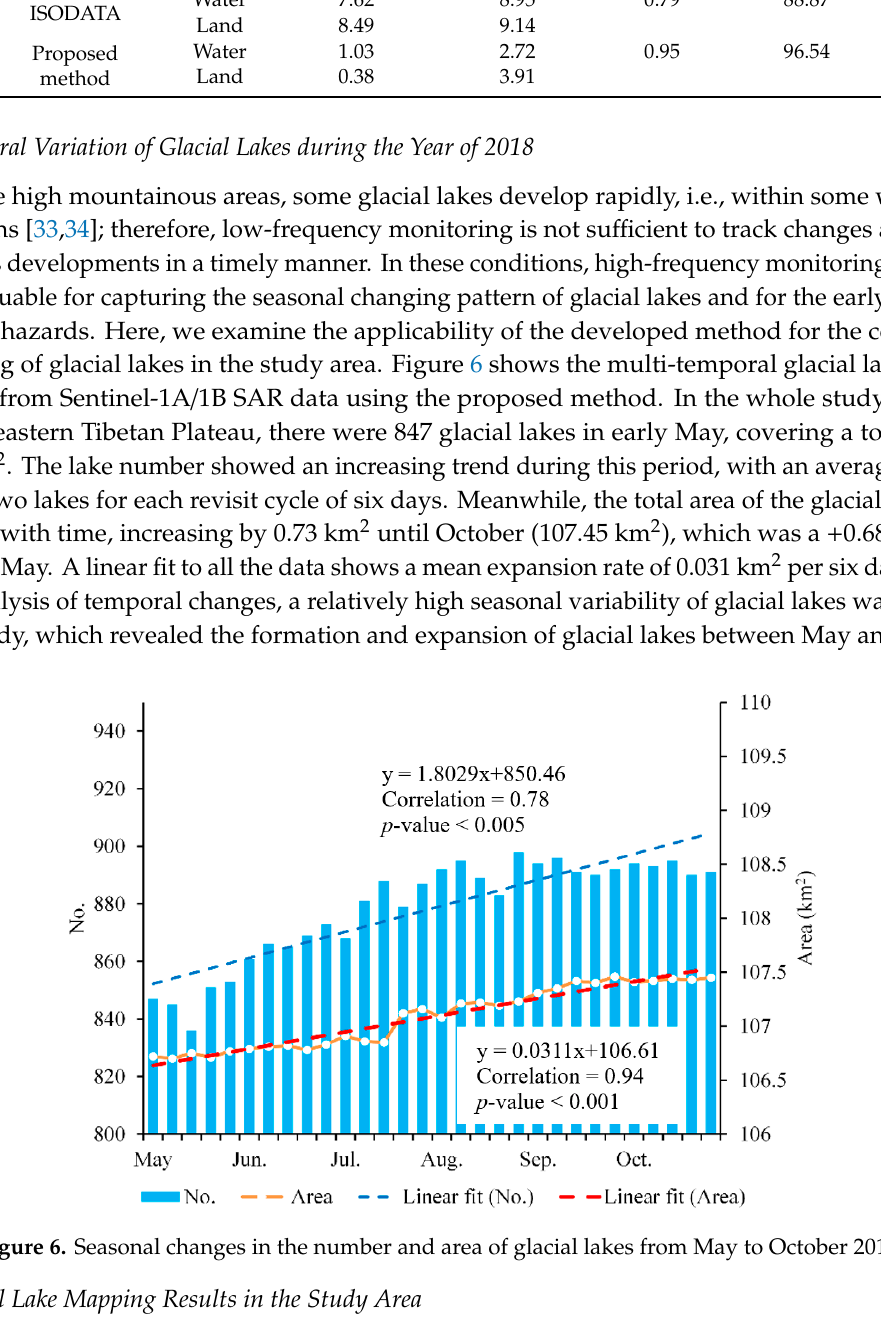
Table 2. Summary of classification accuracy of three di ff erent methods.